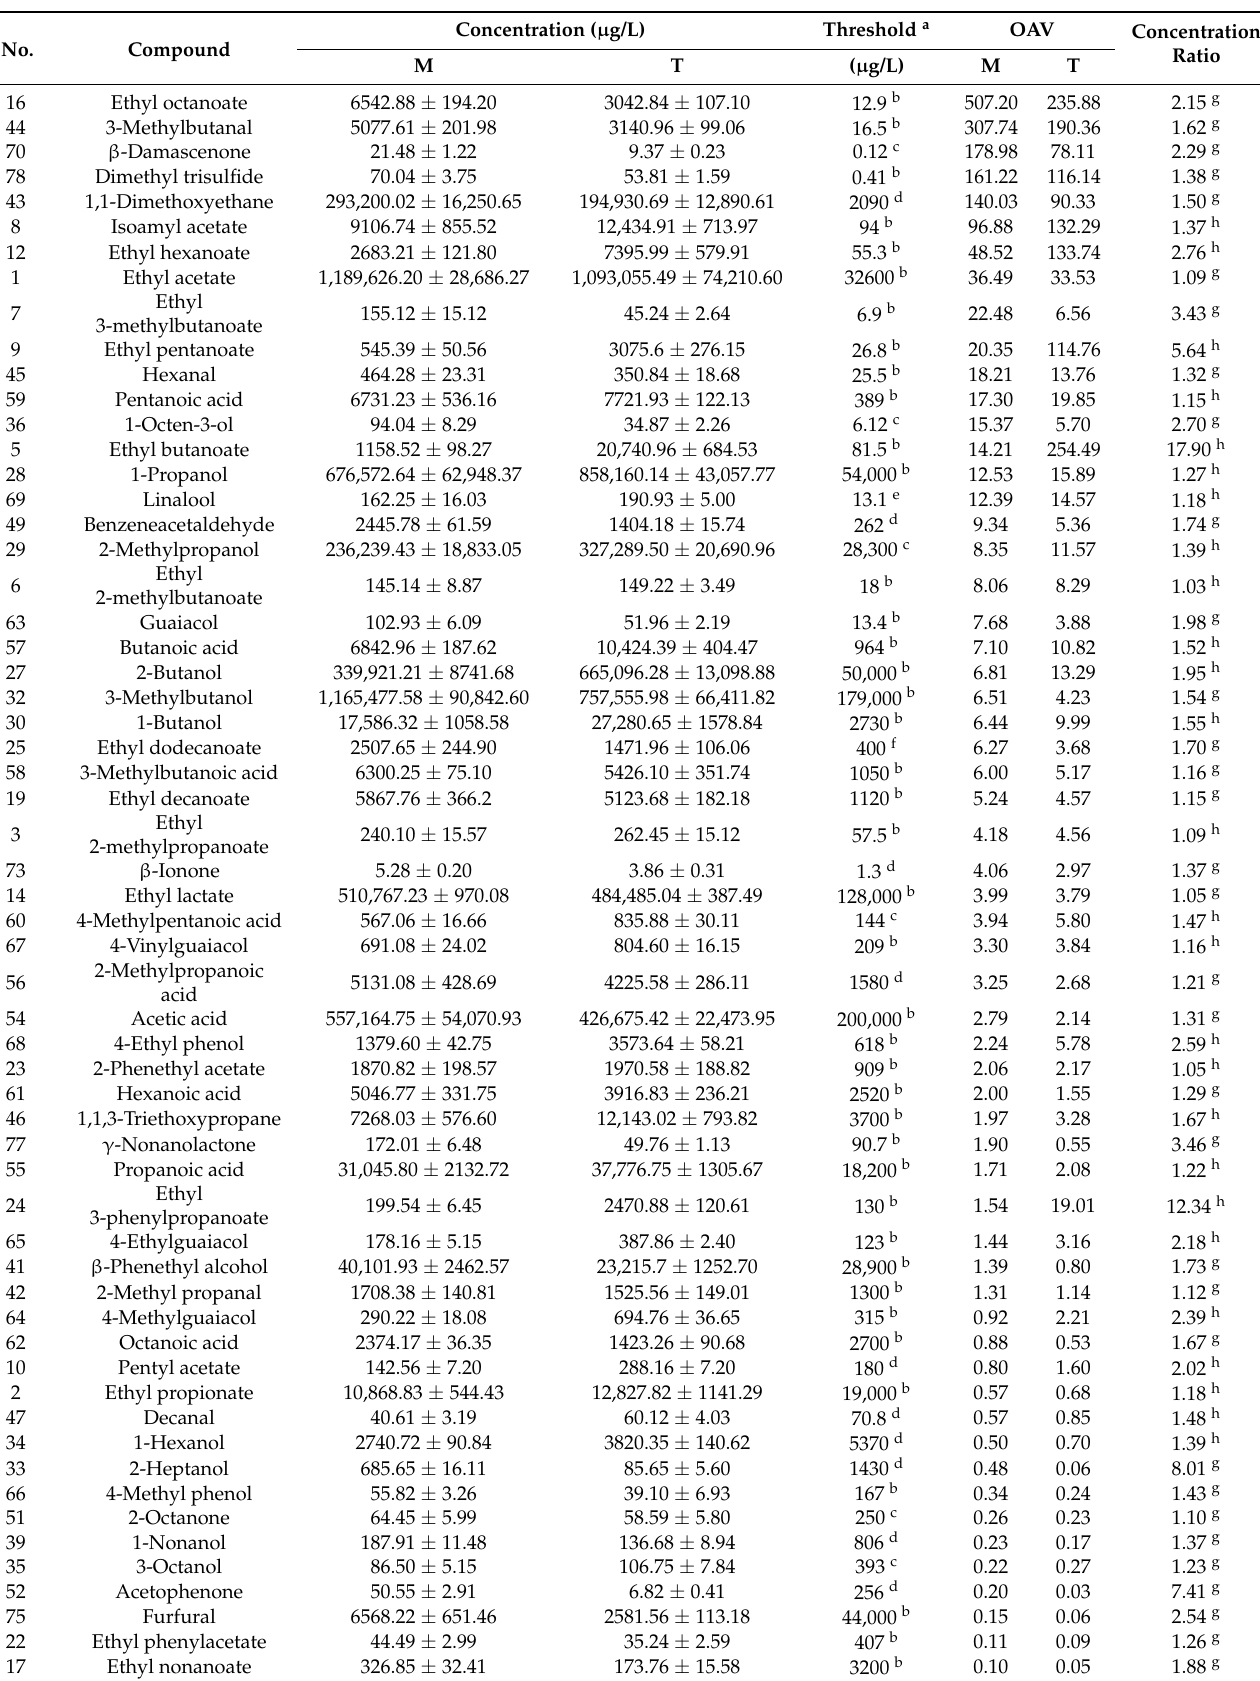
Table 3. Concentrations of aroma compounds, odor thresholds, and odor activity values (OAVs) in Chinese xiaoqu Baijiu.